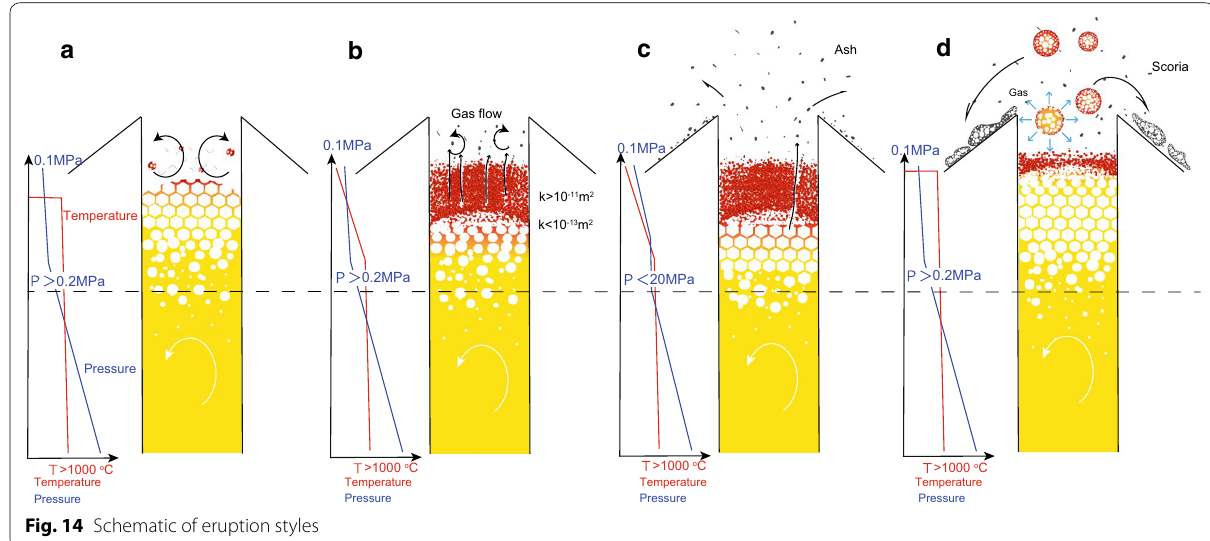
Fig. 14 Schematic of eruption